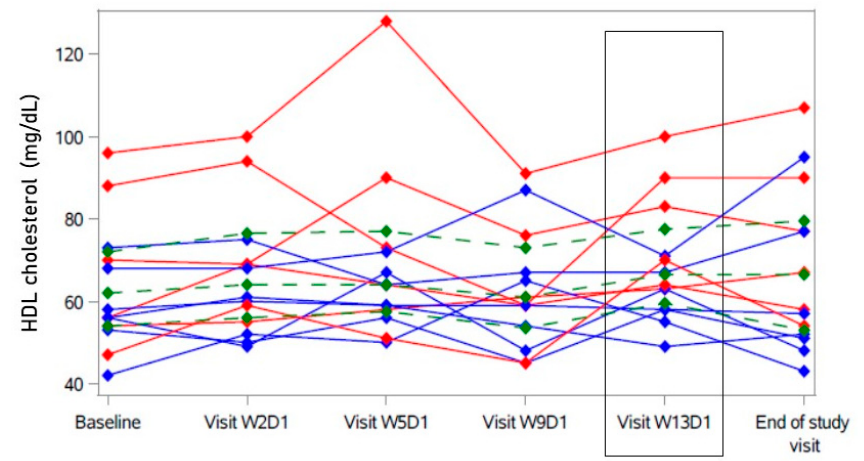
Figure 2. Course of HDL cholesterol under bulevirtide treatment in individual participants. A sec- ondary endpoint was change in HDL cholesterol after 12 weeks of treatment (Visit W13D1, high- lighted). Participants with decrease of LDL cholesterol (primary endpoint) > 19.6 mg/dL in blue (“responder”); participants with no decrease and decrease < 19.6 mg/dL of LDL cholesterol in red (“non-responder”). Green: Hodges–Lehmann estimator with 95% confidence interval.